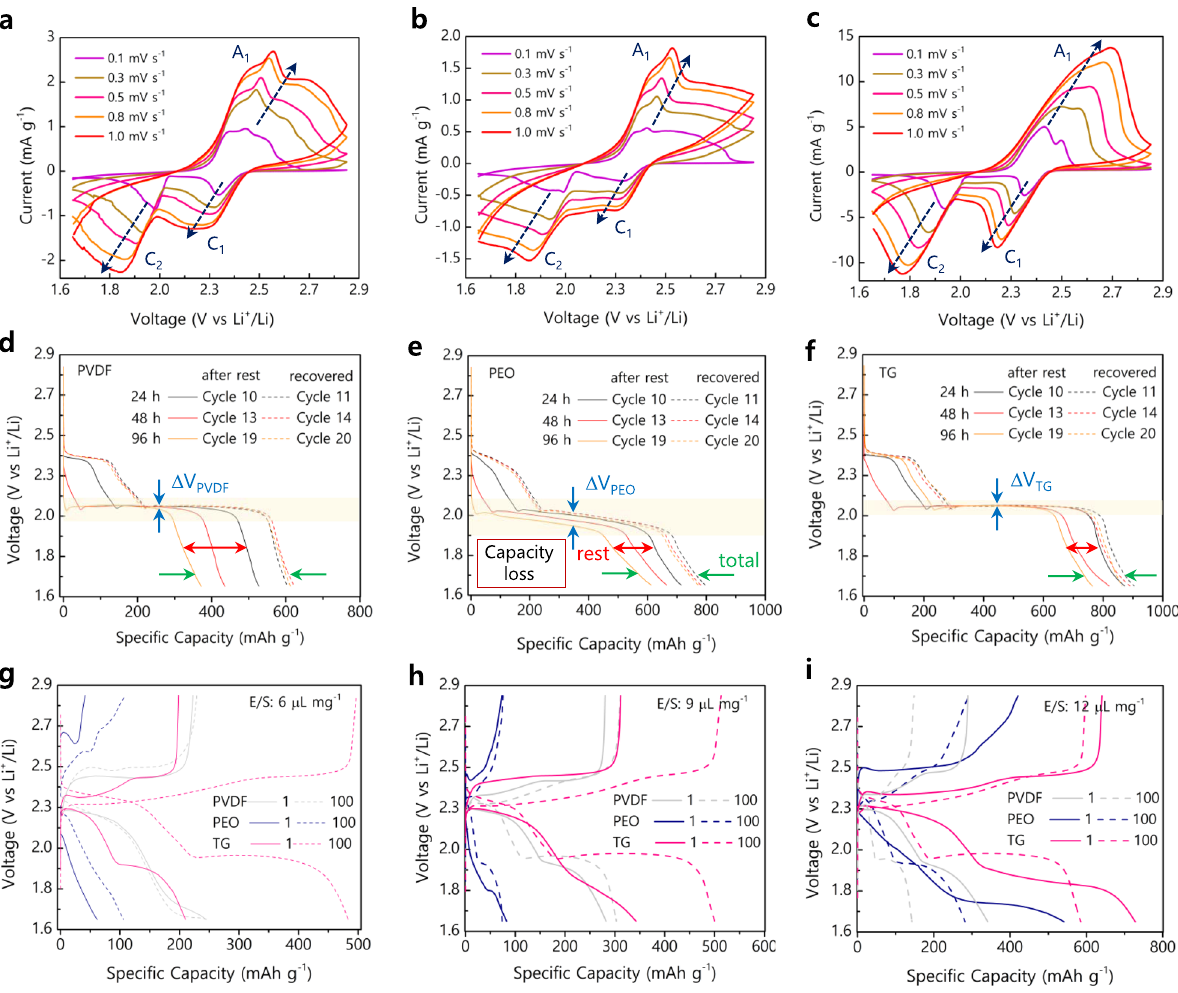
Fig. 4 Electrochemical kinetic, self-discharge, and electrolyte/sulfur ratio studies for S/PVDF, S/PEO, and S/TG cathodes. a – c Cyclic voltammograms at various scan rates of 0.1 – 1 mV s – 1 . d – f Self-discharge pro fi le shown after resting 24, 48, and 96 h and respective recovery cycle. g – i Discharge-charge pro fi le for various electrodes with speci fi ed electrolyte/sulfur ratio E/S 6, 9, and 12 µ L mg – 1